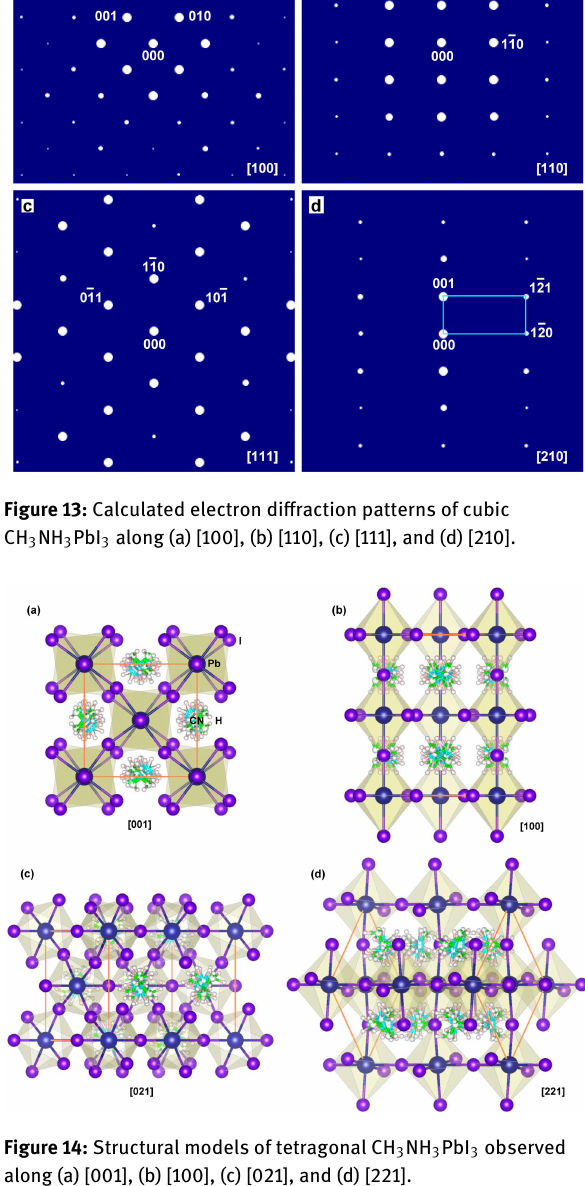
observed along the [100], [110], [111], and [210] directions.